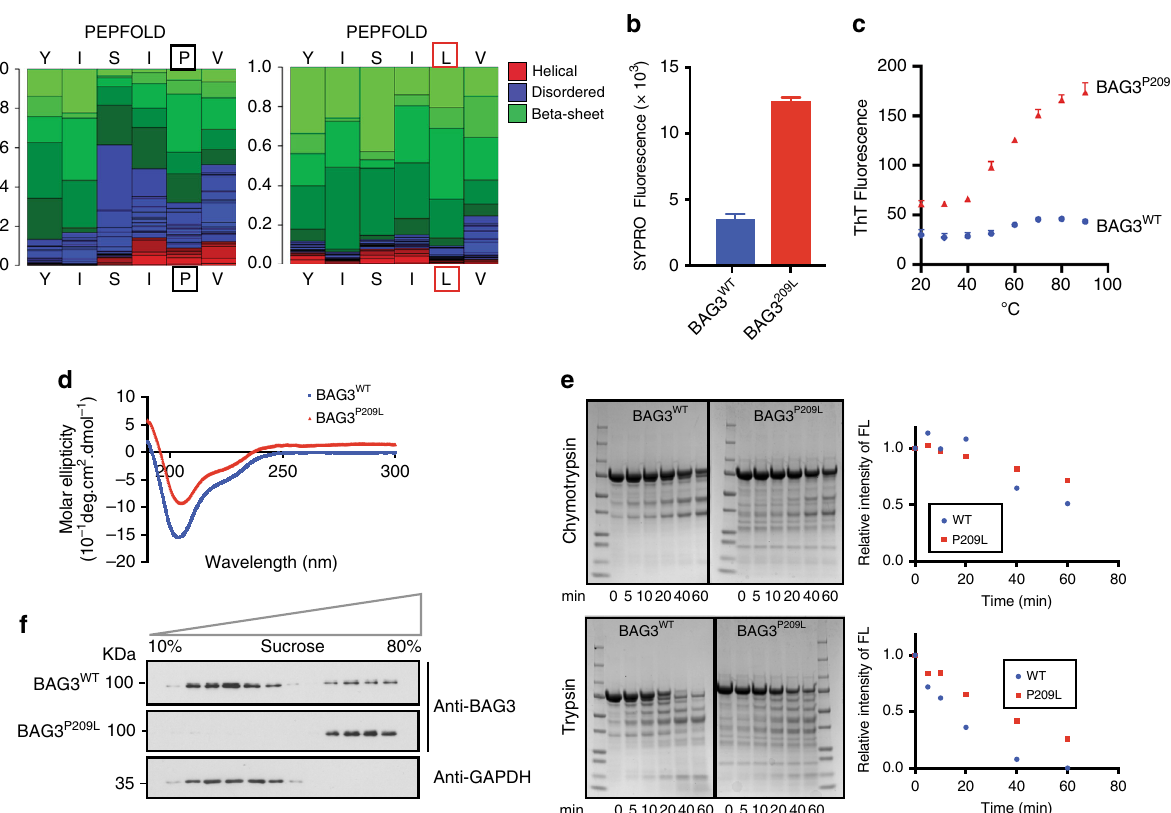
Fig. 3 BAG3 P209L forms soluble oligomers. a Replacing proline for leucine at residue 209 is predicted to increase local beta-sheet content. PepFold was used to estimate propensity to form secondary structure. b Solutions containing recombinant BAG3 wt or BAG3 P209L were stained with SYPRO orange and fl uorescence was measured. Results are the average of at least three independent experiments performed in triplicate each. Error bars represent SD. c Recombinant BAG3 wt or BAG3 P209L solutions were labeled by the beta-sheet dye, thio fl avin T. Results are the average of at least three independent experiments performed in triplicate each. Error bars represent SD. d BAG3 P209L does not have gross changes in secondary structure, as estimated from CD measurements. Results are representative of measurements performed in triplicate. e BAG3 wt or BAG3 P209L solutions were subjected to partial proteolysis with either chymotrypsin or trypsin and samples were loaded on SDS – PAGE for separation. Coomassie stained gels are shown. f Fractionation of